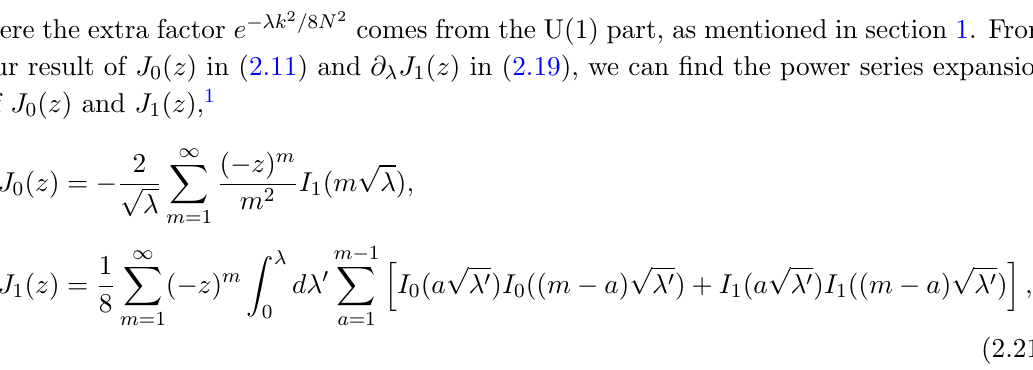
Figure 1 . Plot of W A as a function of k=N for N = 100 ; (cid:21) = 0 : 1. In (a), the red dots represent k log W exact while the blue curve is log W LO . In (b), the red dots represent log( W exact A k A k the blue curve is log( W LO+NLO =W LO A k A k